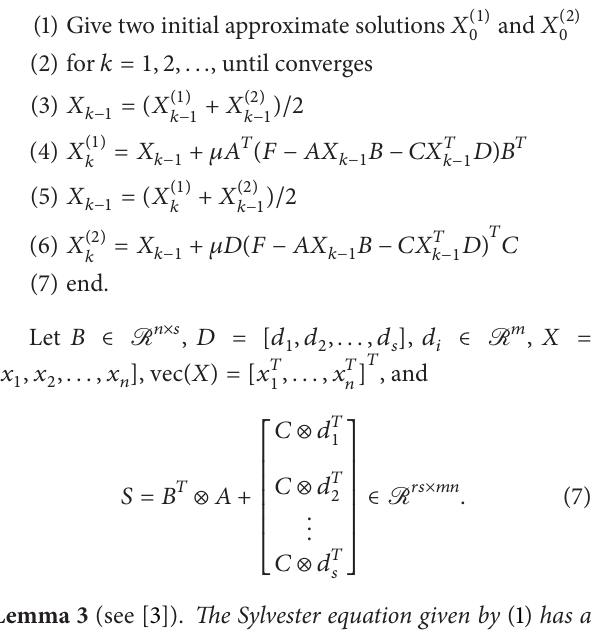
Algorithm 2. The modified gradient based iterative algorithm (MGBI